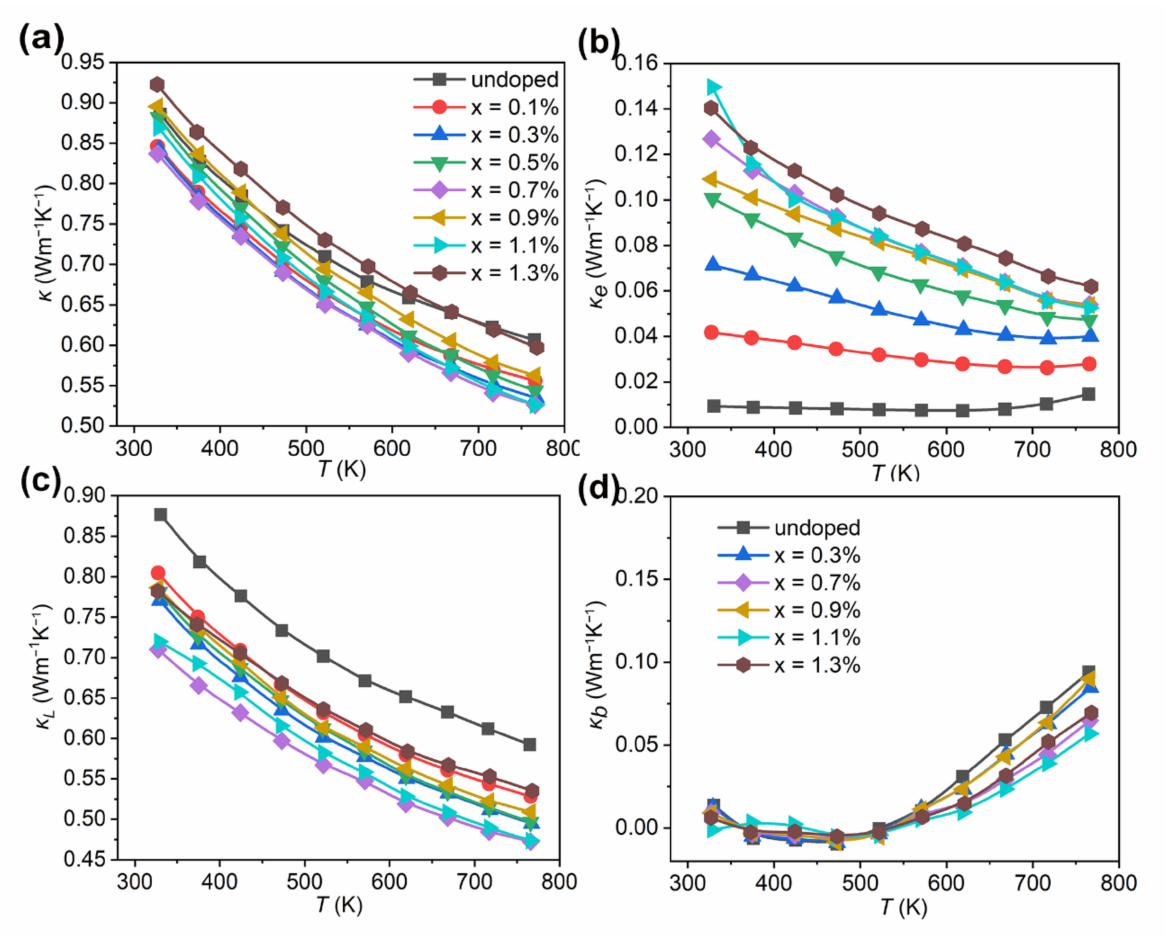
Figure 5. Thermal transport properties for Bi 2 Se 1 − x I x S 2 (x = 0–1.3%). ( a ) Total thermal conductivity ( κ ), ( b ) electronic thermal conductivity ( κ e ), ( c ) lattice thermal conductivity ( κ L ), ( d ) bipolar thermal conductivity ( κ b